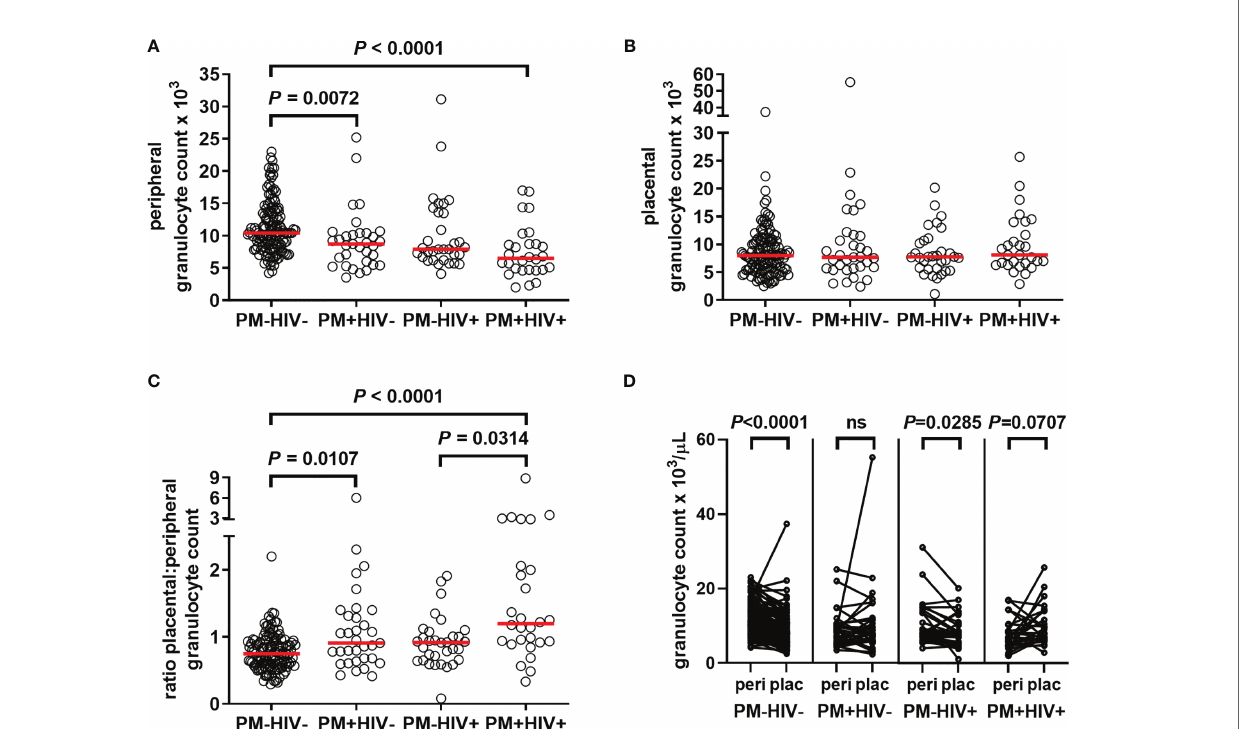
FIGURE 2 | Placental malaria and HIV infections differentially alter granulocyte levels in peripheral and placental blood. Peripheral and placental blood were subjected to complete blood count. Granulocyte numbers in (A) peripheral and (B) placental blood are shown. (C) Depicts the ratio of placental to peripheral blood granulocyte numbers, HIV-/PM-, n = 131; HIV-/PM+, n = 33; HIV+/PM-, n = 32; HIV+/PM+, n = 28. (A – C) Statistics by Kruskal-Wallis test with post-hoc group-wise comparisons by Dunn ’ s multiple comparisons test. (D) , pairwise comparisons by Wilcoxon matched-pairs signed rank test. PM-=placental malaria negative; PM+=placental malaria positive; HIV-=human immunode fi ciency virus seronegative; HIV+=human immunode fi ciency virus